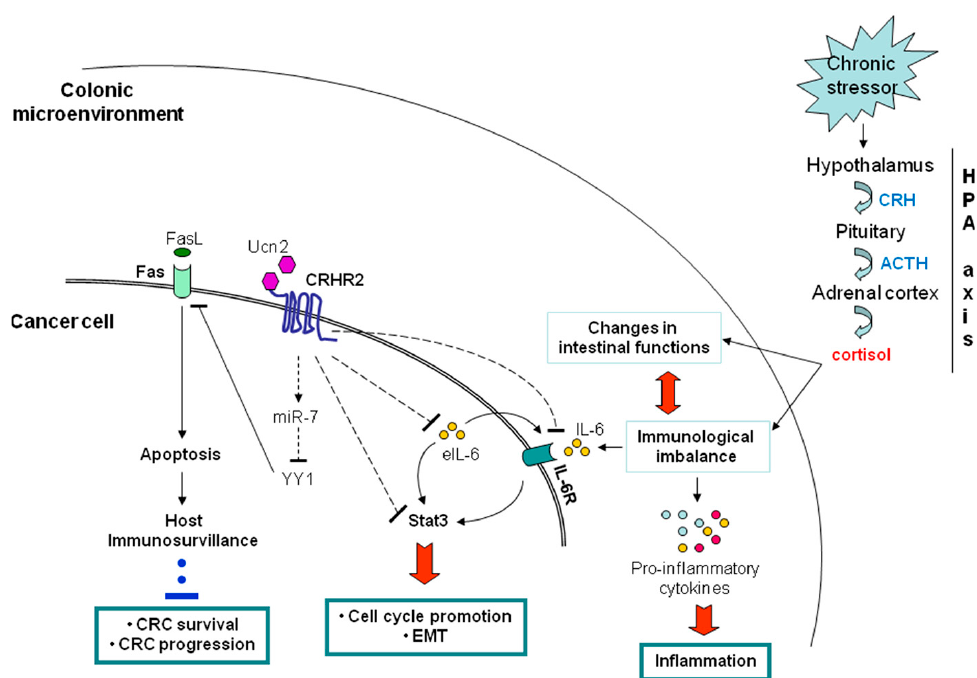
Figure 2. A proposed mechanism for the anti-tumoridical activity of peripheral CRHR2 / Ucn2 signaling in inflammation-related colorectal cancer (CRC). CRHR2 expression has been found significantly diminished in CRC cells. Colonic inflammation, which is often induced by chronic stressors, is characterized by accumulation of several pro-inflammatory cytokines, including IL-6, in the local microenvironment, produced either by infiltrated immune cells, or cancer cells, when present. Experimental evidence demonstrates that when CRHR2 is expressed on cancer cell surface and activated by Ucn2, it can su ffi ciently inhibit the endogenous expression of IL-6 and its receptor, resulting in reduction of IL-6 mediated Stat3-phosphorylation and activation. Stat3 inhibition in CRC cells, a ff ects negatively the expression of STAT-3 target genes involved in cell cycle promotion and EMT, thus repressing CRC growth and metastasis. In addition, CRHR2 / Ucn2 signaling was shown to reverse tumor resistance to Fas-mediated apoptosis in CRC cells by inducing miR-7, a suppressor of YY1, which normally acts as a transcriptional repressor of Fas in cancer cells. The proposed mechanism is an example of how the peripheral CRH system can e ff ectively mediate and control the crosstalk among molecular networks involved in stress-induced inflammation and CRC pathophysiology. Dotted lines represent the CRHR2 / Ucn2-mediated e ff ects on signal transduction pathways in CRC cells. eIL-6, endogenous tumor produced IL-6; EMT, epithelial to mesencymal transition; CRHR2, corticotrophin releasing hormone receptor